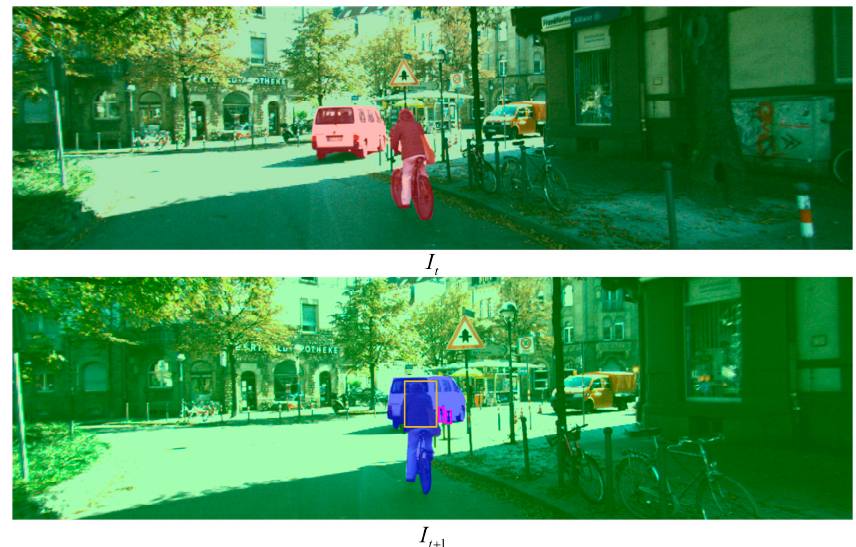
Figure 5. Schematic diagrams of pixel region classification of two adjacent frames. The red shadow represents the dynamic region at the current time, and the green shadow represents the static region. The blue shadow represents the area to be occluded at the next moment. The pink box indicates that static structures occlude dynamic structures in the area, the orange box indicates that dynamic structures occlude each other, and the rest are dynamic structures occlude static structures.